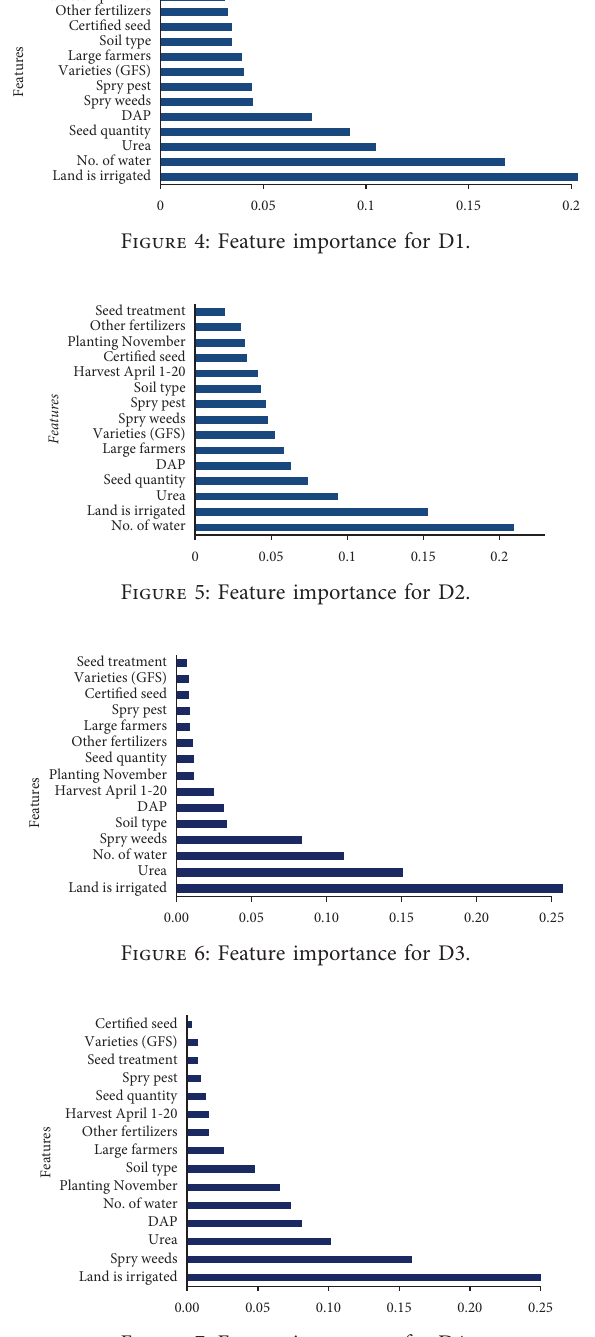
Table 1: Cronbach’s alpha reliability coefficients for various datasets.